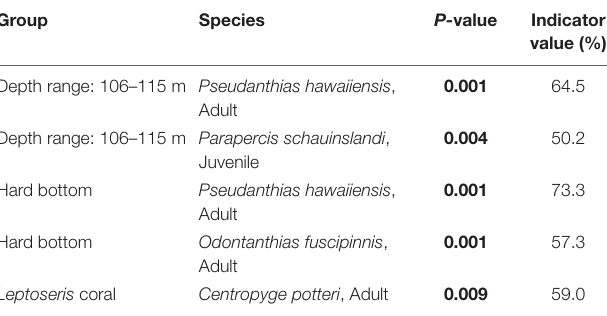
TABLE 6 | Groups and their indicator